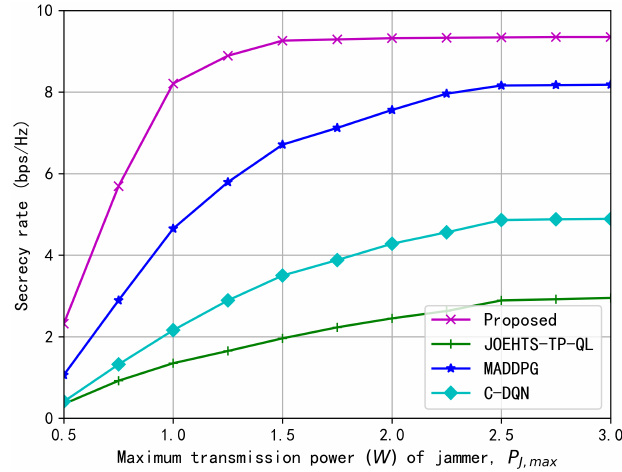
Figure 7. Secrecy rate versus maximum transmission power of jammer.